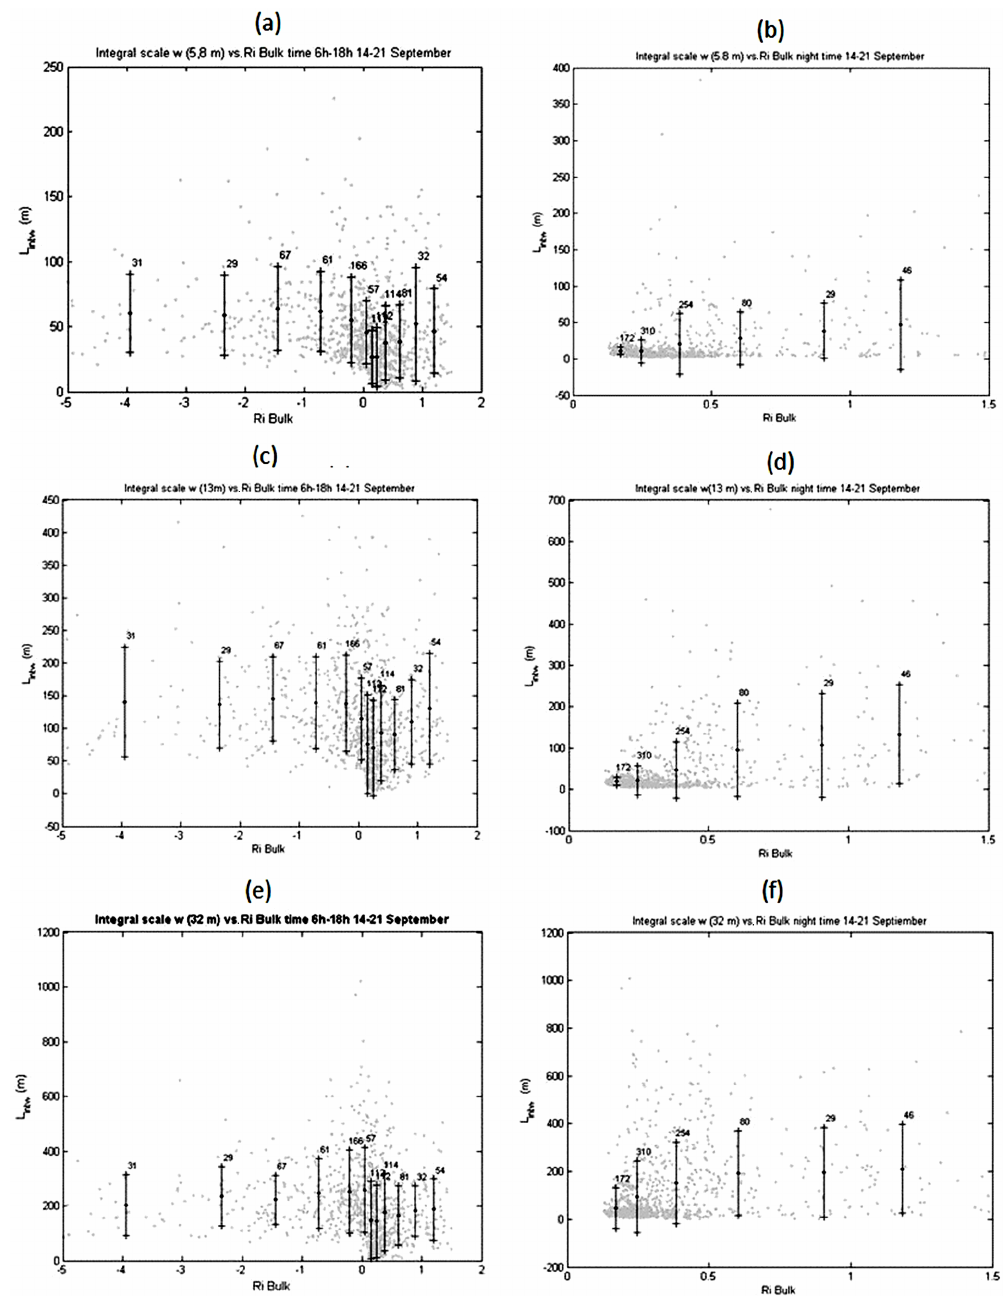
Figure 9. Integral length scales of the w (cid:48) component plotted against the bulk Richardson number at 5.8, 13 and 32m. (a) , (c) and (e) diurnal hours; (b) , (d) and (f) night